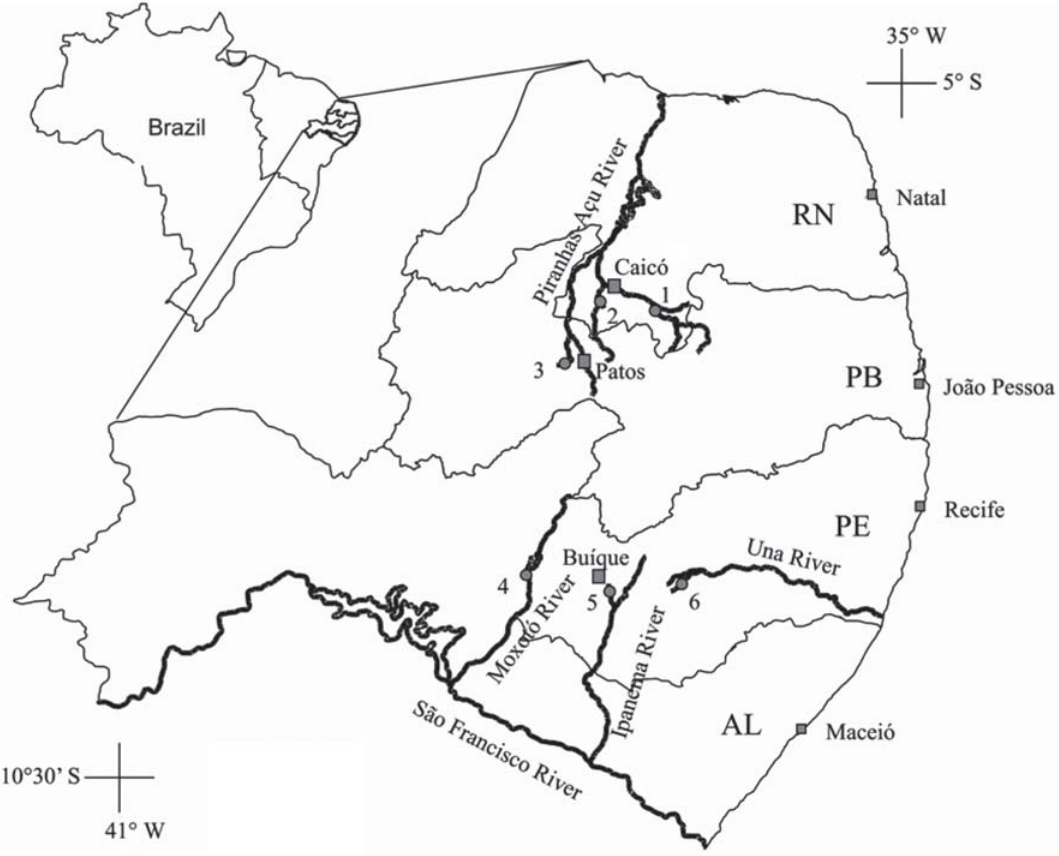
Fig. 1. Study areas showing Seridó/Borborema - RN/PB and Buíque/Vale do Ipojuca - PE. Towns and cities are denoted by squares. Study sites are: 1 - Seridó River, 2 - Cipó stream, 3 - Recanto Reservoir, 4 - Escama-Peixe stream, 5 - Mulungú Reservoir, and 6 - Gurjão